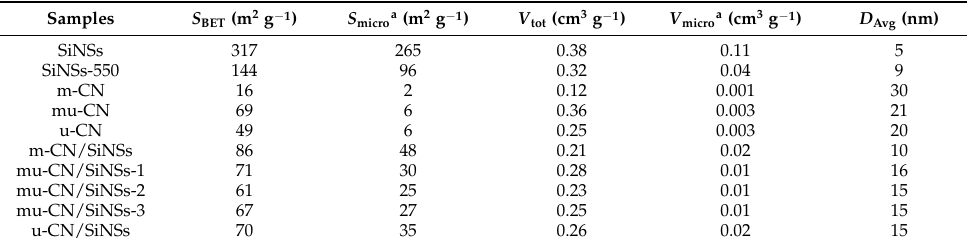
Table 1. Textural properties of the SiNSs, SiNSs-550, CNs, and CN/SiNSs composites.